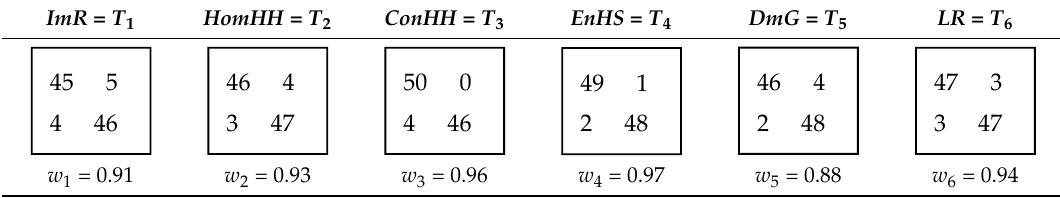
Table 4. The selected features, their confidence indicators and the representatives for the class F . Patch